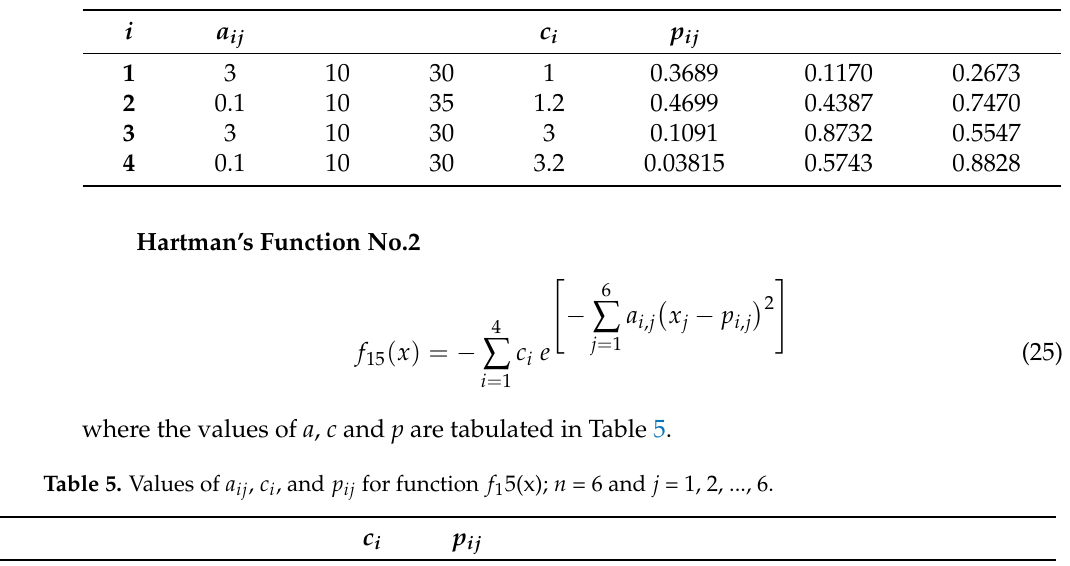
Table 4. Values of a ij , c i , and p ij for function f 1 4(x); n = 3 and j = 1, 2, 3.